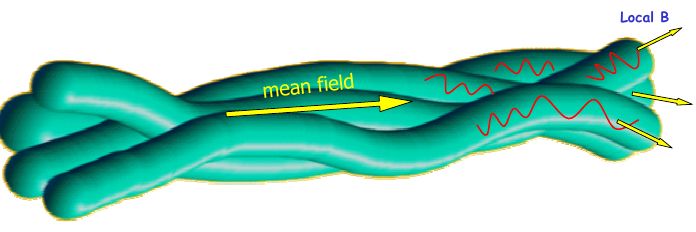
Figure 101: Simple visualization of hypothetical flux tubes which tangle up in space. Each flux tube is characterized by a local field direction, and within each flux tube the presence of Alfv´enic fluctuations makes the magnetic field vector randomly wander about this direction. Moreover, the large scale is characterized by an average background field direction aligned with the local interplanetary magnetic field. Moving across different flux-tubes, characterized by a different values of | 𝐵 | , enhances the intermittency level of the magnetic field intensity time series (cf. Bruno et al. ,